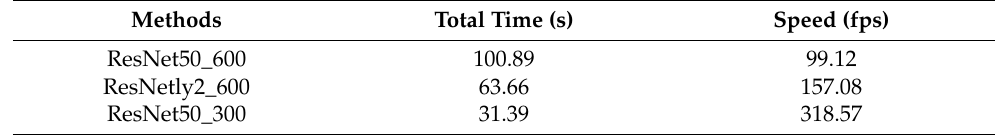
Table 2. Network time consumption under different backbones and